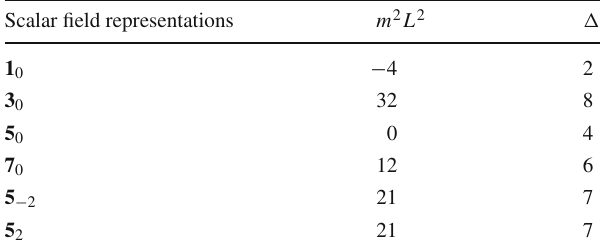
Table 1 Scalar masses at the N = 4 supersymmetric AdS 5 critical point with U ( 1 ) × SO ( 3 ) symmetry and the corresponding dimensions of dual operators for the non-compact U ( 1 ) × SL ( 3 , R ) gauge group. The scalars are organized into representations of U ( 1 ) × SO ( 3 ) with the singlet corresponding to the dilaton (cid:2) Scalar field